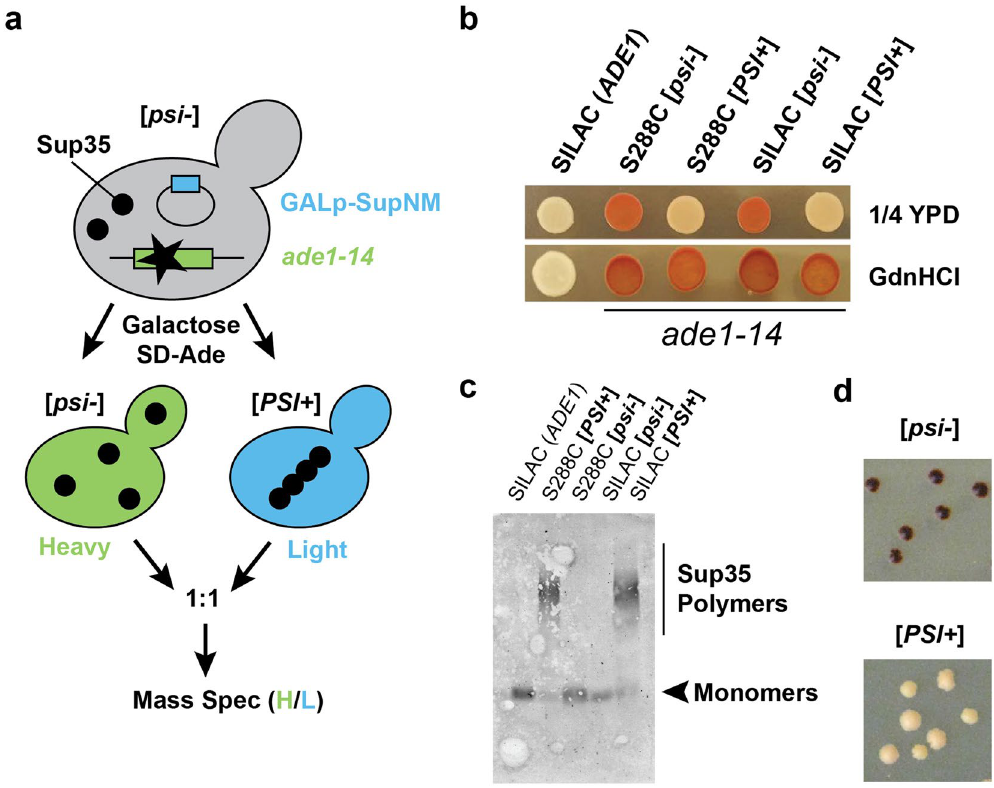
Figure 1. Establishment of the [ psi − ] and [ PSI + ] strains for SILAC analysis. ( a ) Schematic diagram of the SILAC approach. [ PSI + ] cells were generated following the galactose-induced overexpression of exogenous Sup35NM, and selection of ade1-14 cells in media lacking adenine. ( b ) Indicated strains were grown in the indicated plates. ( c ) SDD-AGE of the lysates of the indicated strains with anti-Sup35 antibodies. ( d ) Colonies from [ PSI + ] SILAC and [ psi − ] SILAC cells that were grown for 5 days on 1/4 YPD plates (see also Fig.